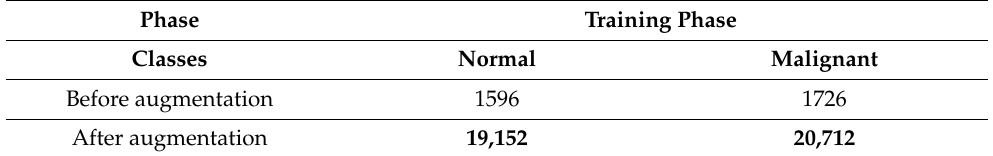
Table 2. Data augmentation for histopathological images to balance the data set during the training